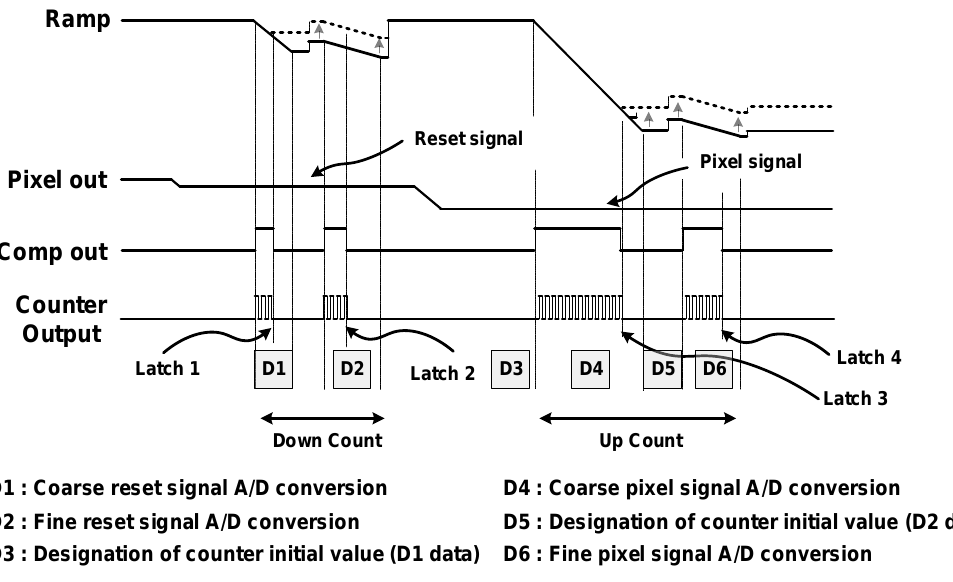
Figure 7. Timing diagram of the proposed digital